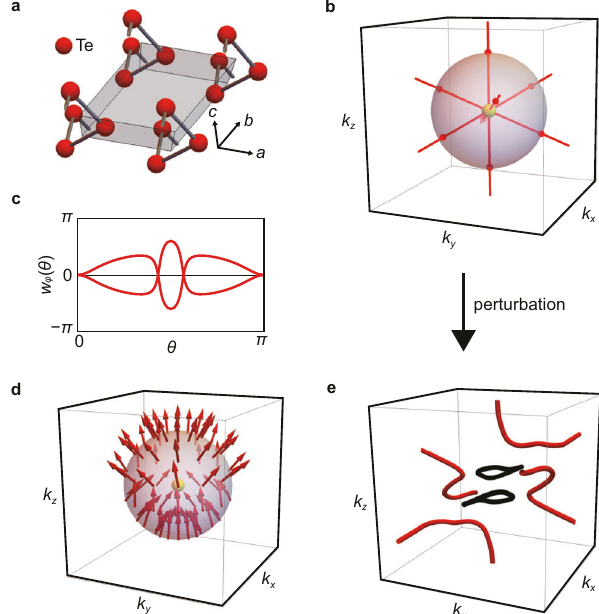
Fig. 5 Acoustic phonon of tellurium. a The lattice structure of tellurium with space group P3 1 21. b By using the values of the stiffness tensor in Materials Project 68 , we fi nd that away from the triple point, the red nodal lines occur only between the two lowest energy bands so that q can be de fi ned. c The Wilson loop spectrum shows trivial winding structure, and therefore, e ¼ 0. d The wavefunction texture of the highest energy band shows trivial skyrmion texture, which is consistent with the constraint that 2 n sk ¼ e . e , We perturb the dynamical matrix such that the degeneracy of TATP in b is lifted (note, however, that these perturbations break the continuous translation symmetry, since the triply degenerate Goldstone mode disappears.). The black nodal lines formed by the two highest energy bands are created. As opposed to the case with nontrivial q in Fig. 3d, the nodal structure in e does not have link between the red and black nodal lines because q is